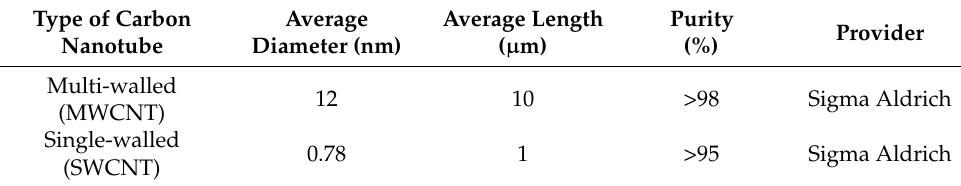
Table 2. Carbon nanotube